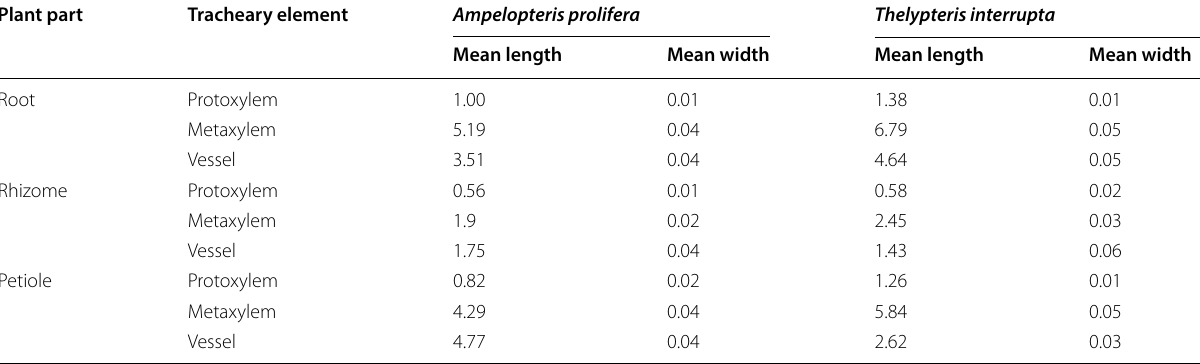
Taxa mean was calculated from population mean for each